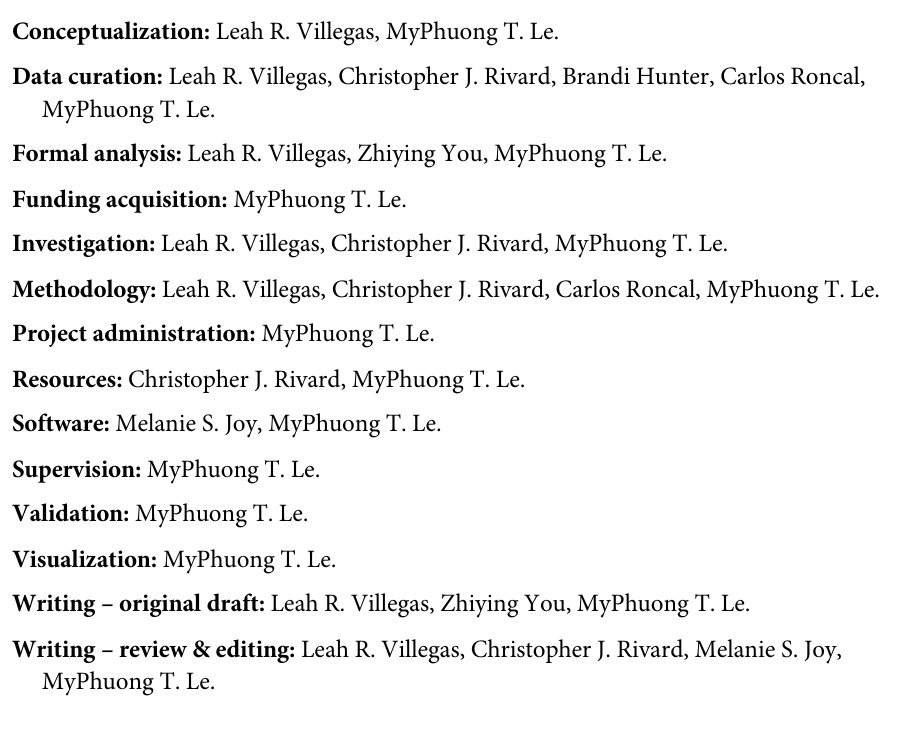
S5 Table. Data for whole blood to plasma ratio of fructose. CRBC = concentration in red blood cells. CPL = concentration in plasma. K = whole blood to plasma concentration b/p